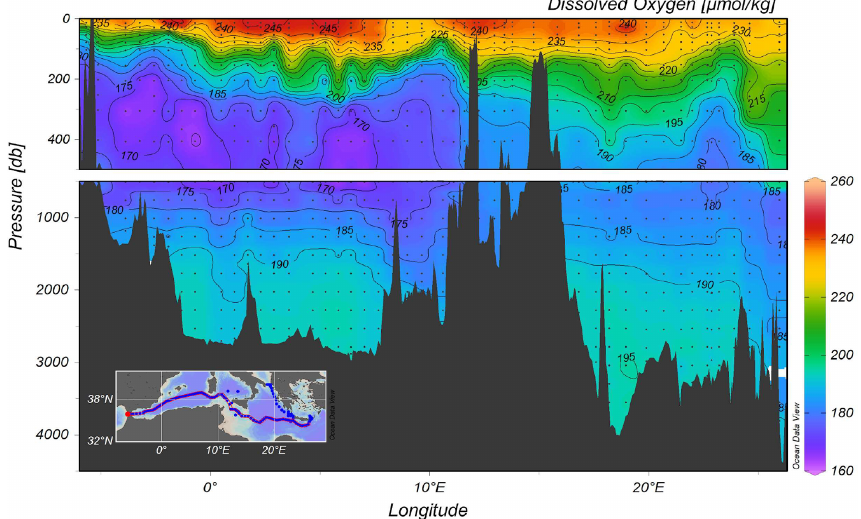
Figure 5. Distribution of dissolved oxygen along the trans-Mediterranean